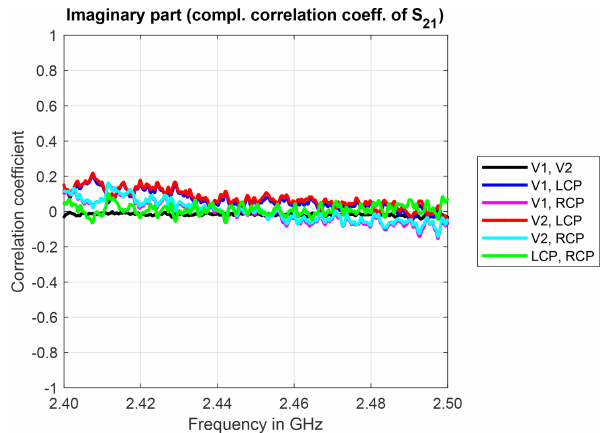
Figure 8. Imaginary part of the complex correlation coefficients for different antennas and measurement trial